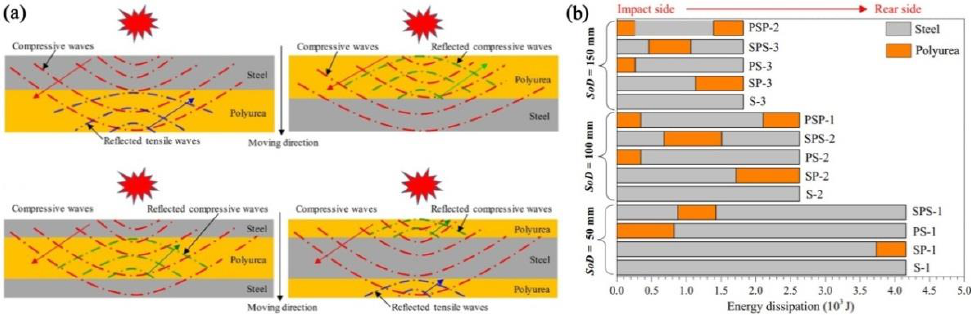
Figure 9. ( a ) Schematic of stress wave propagation in different structures and ( b ) the energy dissipation of each layer. Reproduced with permission from ref. [34].